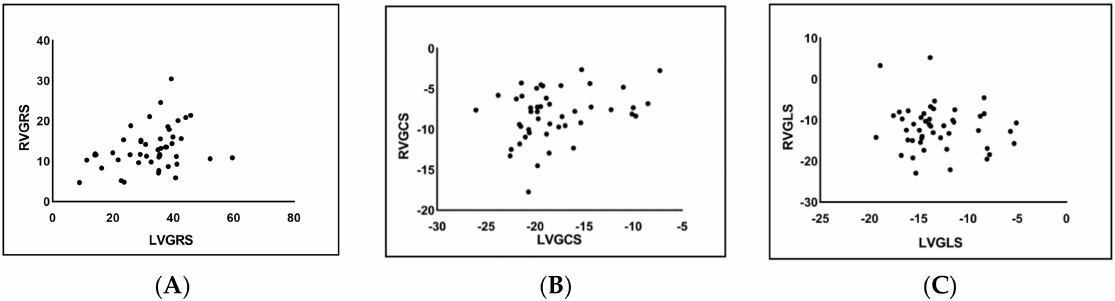
Figure 4. Scatter plots of global radial strain (GRS) ( A ), global circumferential strain (GCS) ( B ), and global longitudinal strain (GLS) ( C ) in the left and right ventricles of PAH patients.